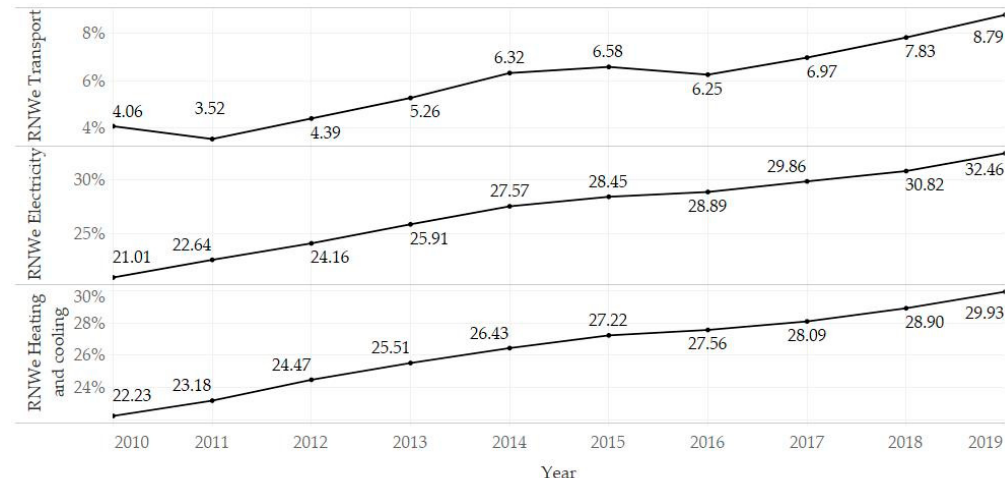
Figure 1. Development of the share of energy from renewable sources in total energy consumption (%) in the observed period (2010–2019).